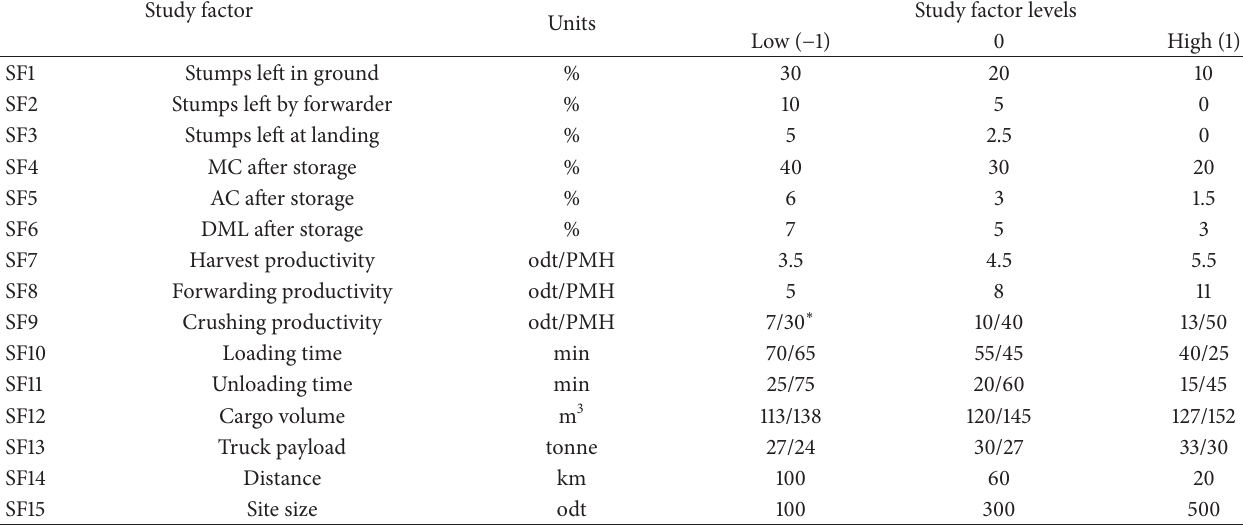
Table 2: List of the selected study factors (SF1-15) and their predefined low ( − 1), expected (0), and high levels (1).